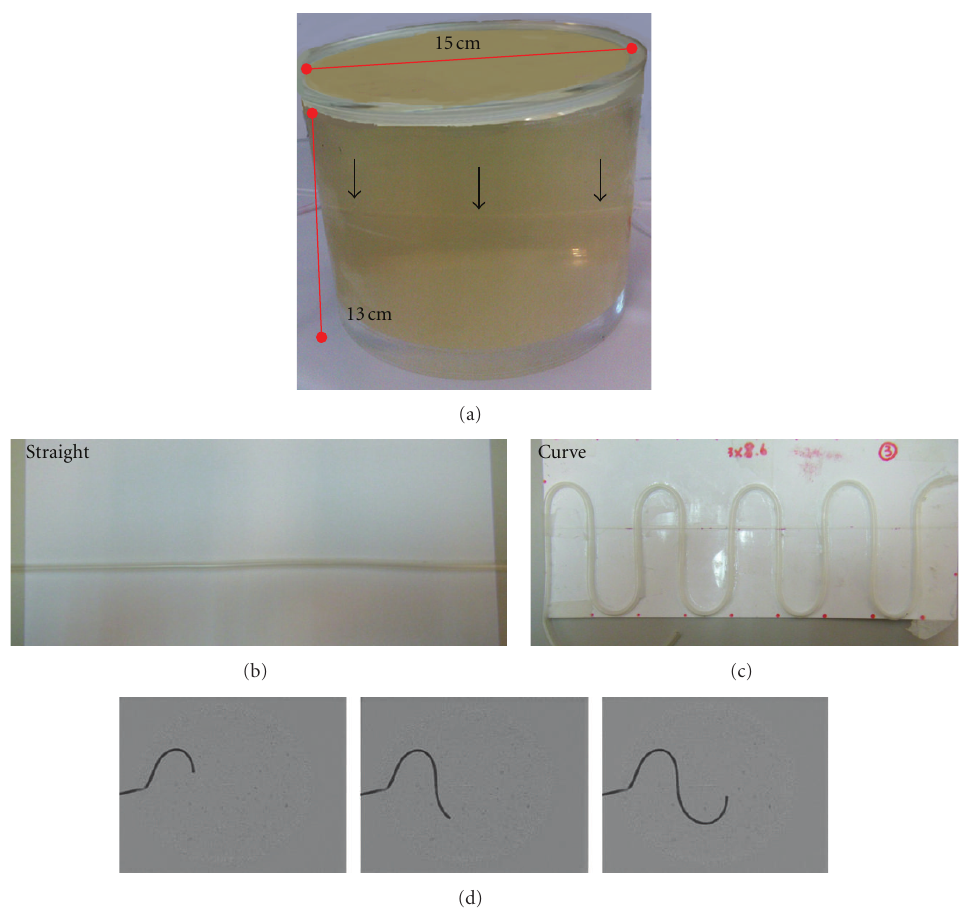
Figure 1: Phantom (a) filled with gelatin; (b) plastic tubes—straight; (c) Plastic tubes—curve; (d) an example